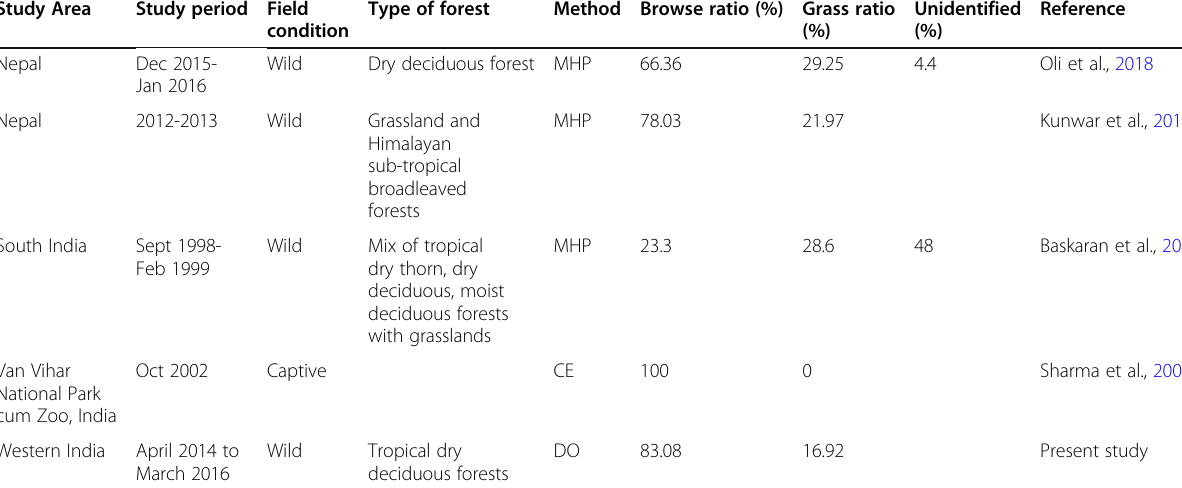
Table 4 A comparison of browse-grass ratio in diet of four-horned antelope ( Tetracerus quadricornis ) in different conditions and forest types Study